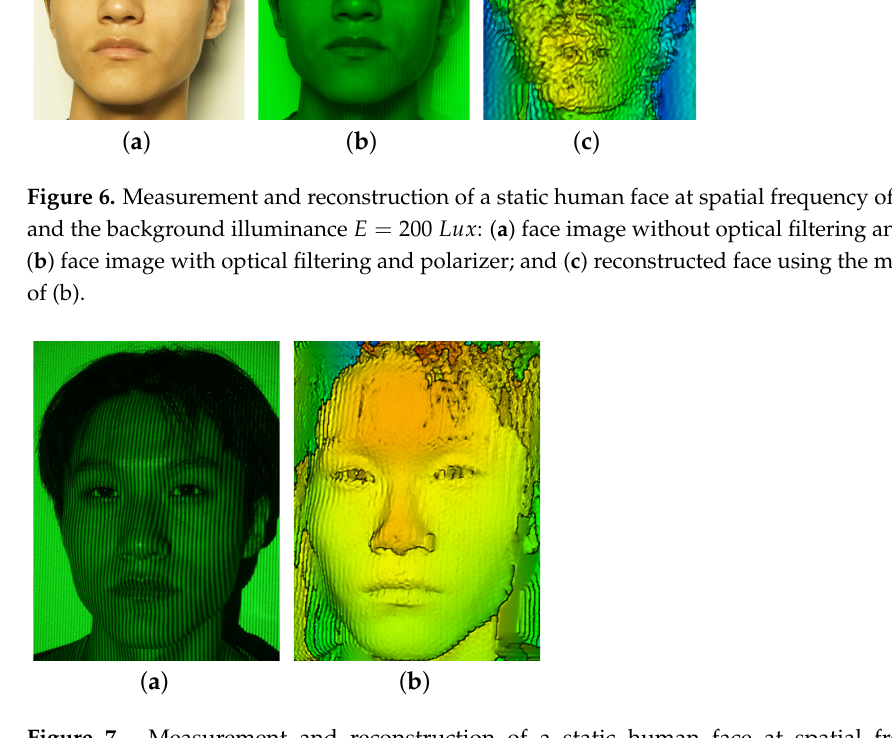
Figure 7. Measurement and reconstruction of a static human face at spatial frequency of 0.3 lp /mm and the background illuminance E = 0: ( a ) face image with projected fringe pattern; and ( b ) reconstructed face using the measurement of